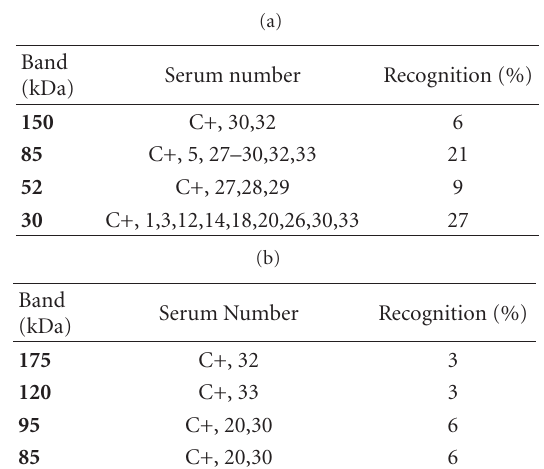
Table 4: (a) Recognition percentage of T. solium cysticerci E/S Ag by 33 hamster sera infected with T. solium tapeworms. (b) Recognition percentage of the 33 hamster sera infected with T. solium tapeworms on antigens of T. solium cysticerci